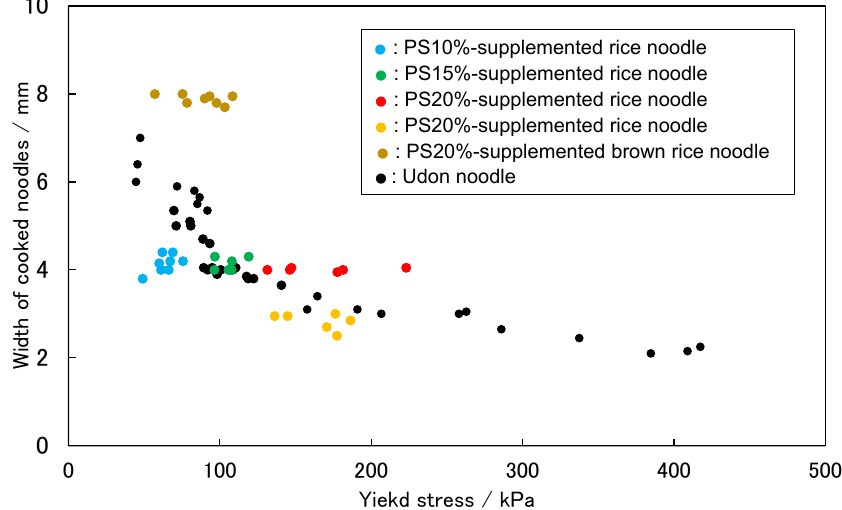
Figure 7. Relationship between yield stress and width of cooked noodles.